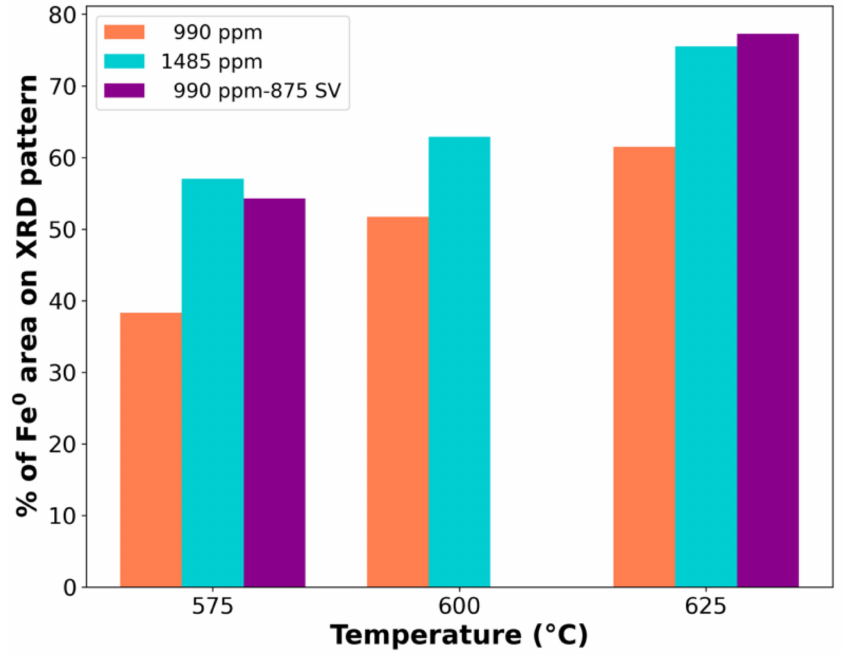
Figure 6. Percentage of Fe 0 remaining in the Fe/CAG spent catalyst at different conditions. Each experiment is denoted with the toluene concentration in the feed. All experiments were carried out at 700 mL/(min · g cat ), except for spent catalysts marked 875 SV, which were performed at 875 mL/(min · g cat